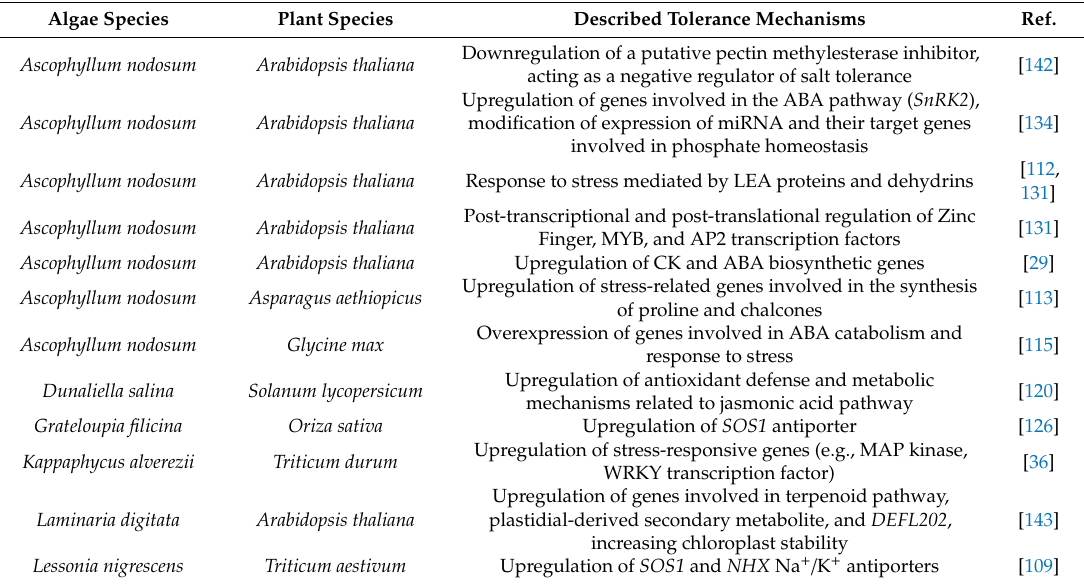
Table 3. A summary of the biostimulatory actions of algal extracts application on molecular mechanisms of plants under salinity. ABA: abscisic acid, AP2: Apetala 2, CK: cytokinins, DEFL202: Lam-induced defensin-like 202, LEA: late embryogenesis-abundant; MAP: mitogen-activated protein, MYB: MYB Proto-Oncogene, NHX antiporters: Na + ,K +/ H + antiporters, SnRK2: SNF1-related protein kinases, SOS1: Salt Overly Sensitive 1, WRKY: transcription factors containing the WRKY